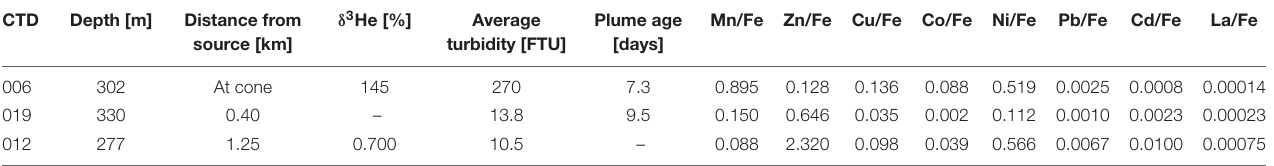
TABLE 1 | Element/Fe ratios [mol/mol], δ 3 He, turbidity values, and Ra-isotope derived plume ages in the plume maximum at ∼ 300 m for three CTD casts at Macauley with distance from the source. CTD Depth